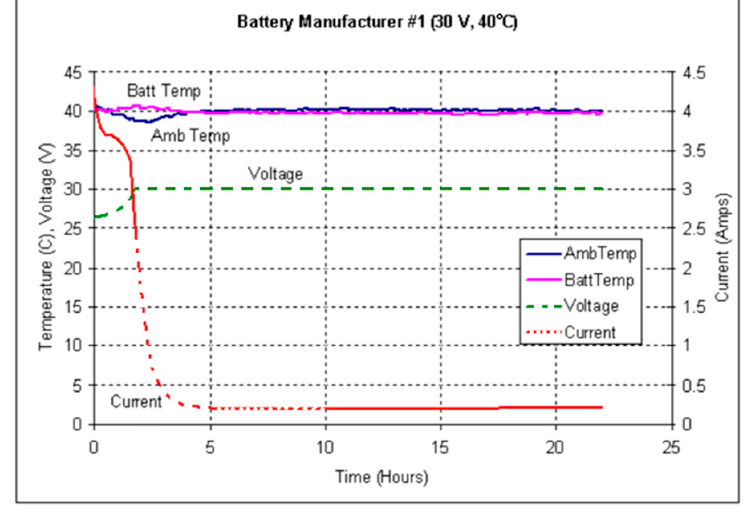
Figure 11. Ambient and battery temperature, voltage, and current over 23 h